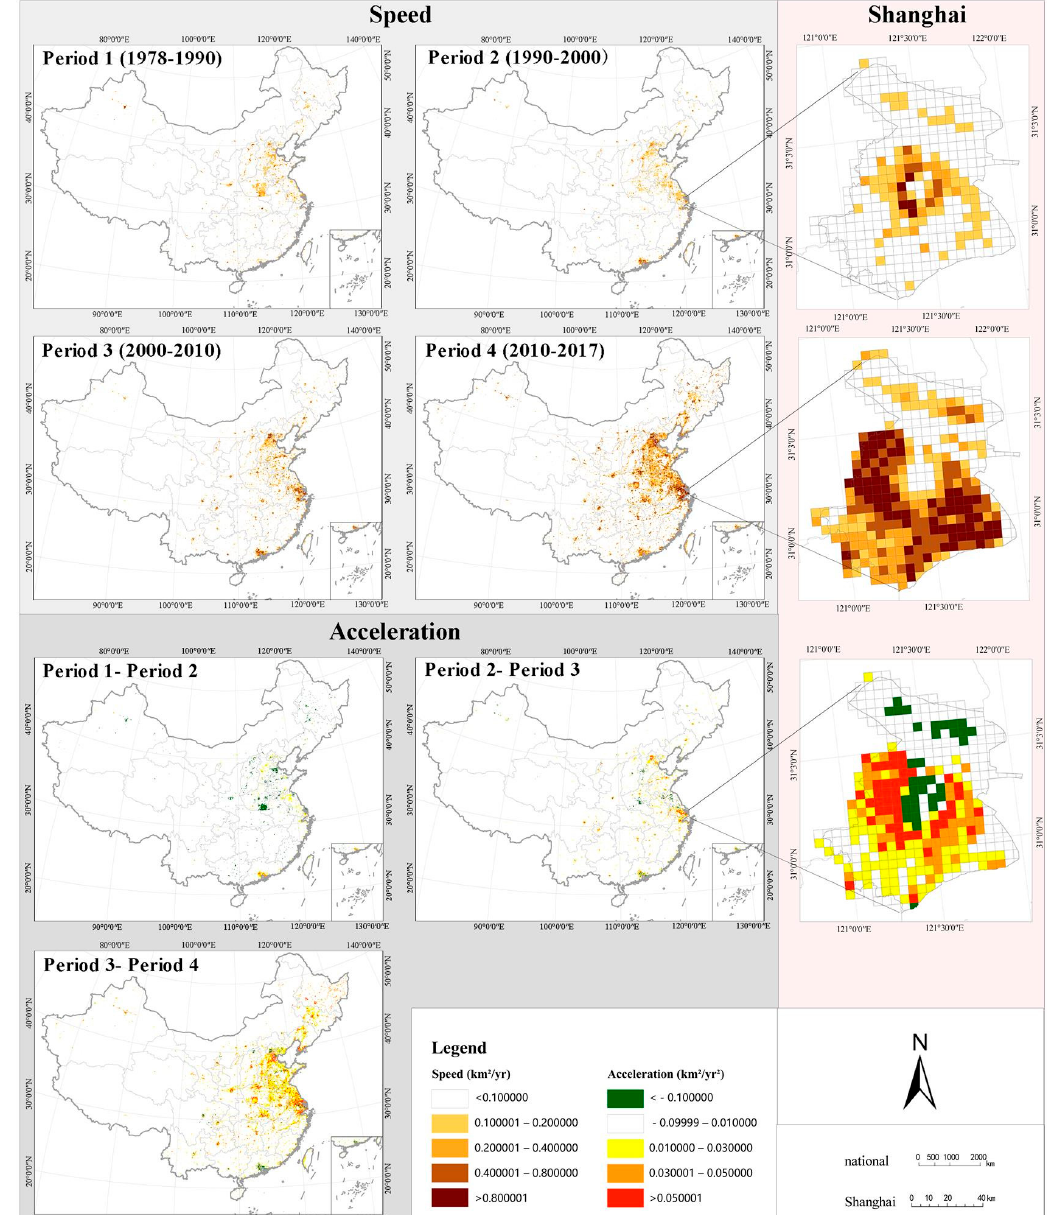
Figure 5. Mapping results of expansion speed and acceleration at the national and city level.